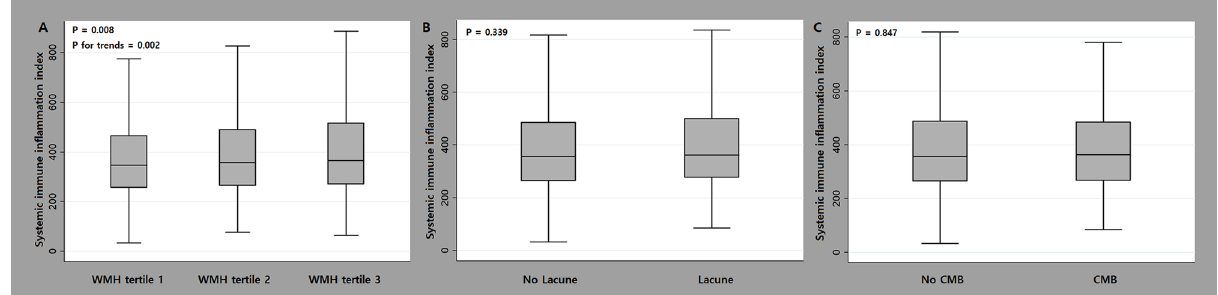
Figure 1. The relationship between the systemic immune-inflammation index and each subtype of cerebral small vessel disease. The systemic immune-inflammation index (SII) showed a significant association with white matter hyperintensity volume tertile ( P = 0.008) in a positive dose–response manner ( P for trend = 0.002). Conversely, the SII did not show any significant association with lacunes ( P = 0.339) or cerebral microbleeds ( P =